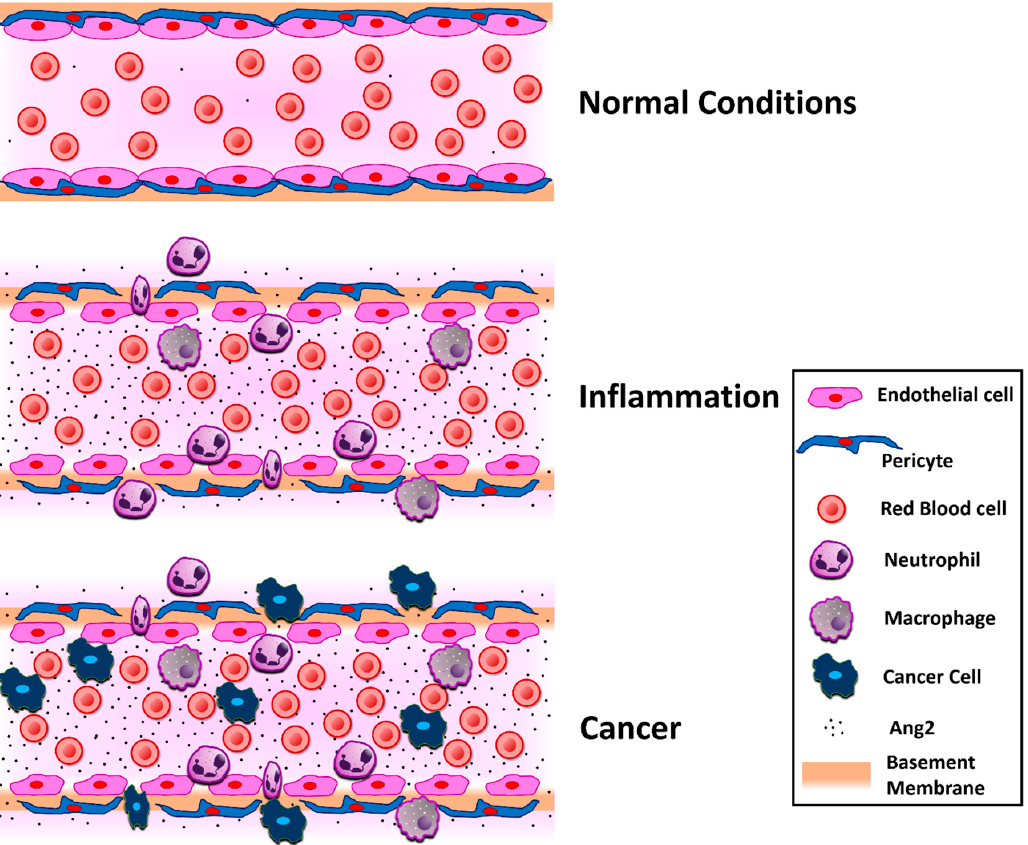
Figure 1. Schematic representation of the Ang2 effect on the vascular bed in normal conditions, inflammation, and cancer. Under normal physiological conditions, Ang2 levels are low, but are upregulated during inflammation or cancer. Ang2 acts on endothelial cells, increasing endothelial permeability and also on the pericytes, causing pericyte detachment from the basement membrane, further inducing vascular leakiness, immune or/and cancer cell trans-endothelial migration, and deterioration of the condition. Ang2 has been proposed as a marker for inflammatory conditions and cancer.